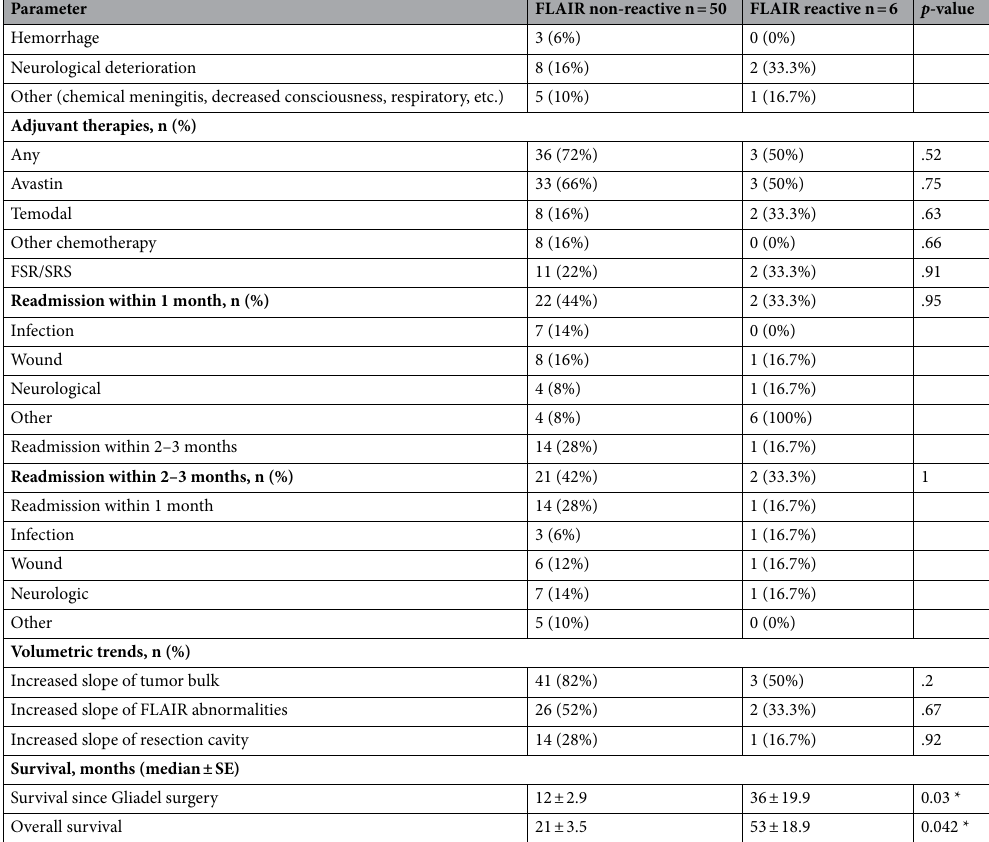
Table 3. Demographic and survival characteristics of 56 patients who underwent implantation of Gliadel Wafers for Recurrent Glioblastoma between 2005 and 2016, stratified by FLAIR reactivity. SE, standard error FLAIR, T2 Weighted fluid-attenuated inversion recovery; IDH, Isocitrate dehydrogenase; KPS, Karnofsky performance scale. FSR, Fractionated stereotactic radiotherapy; SRS, Stereotactic radiosurgery * p < .05, ** p < .01, *** p < .001.